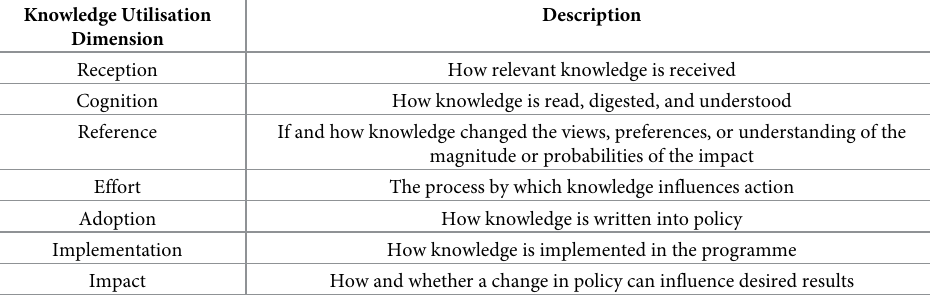
Table 2. Seven dimensions of the knowledge utilisation